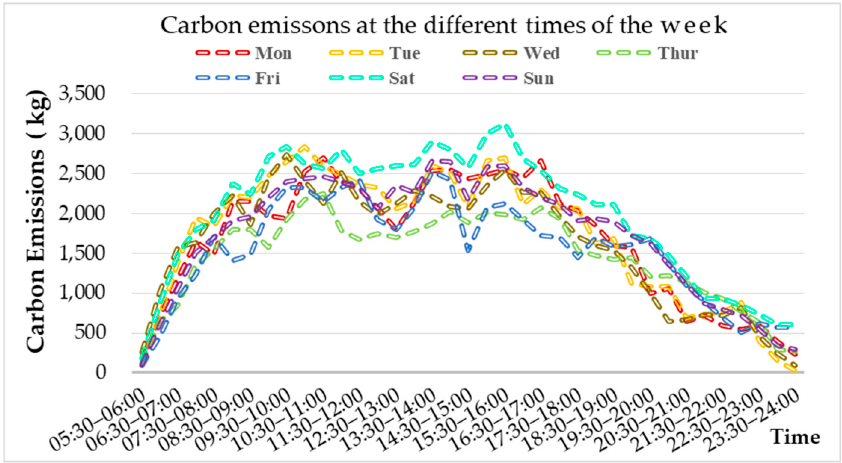
Figure 5. Time distribution of buses’ carbon emissions in Sanya of the